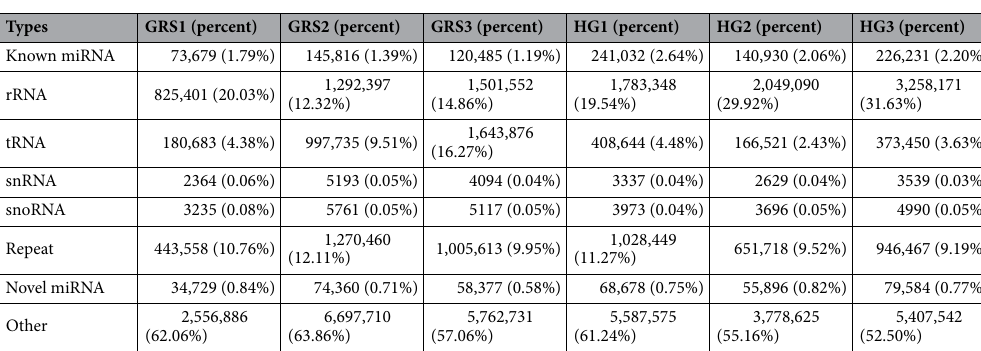
Table 1. Statistical overview of various sRNA